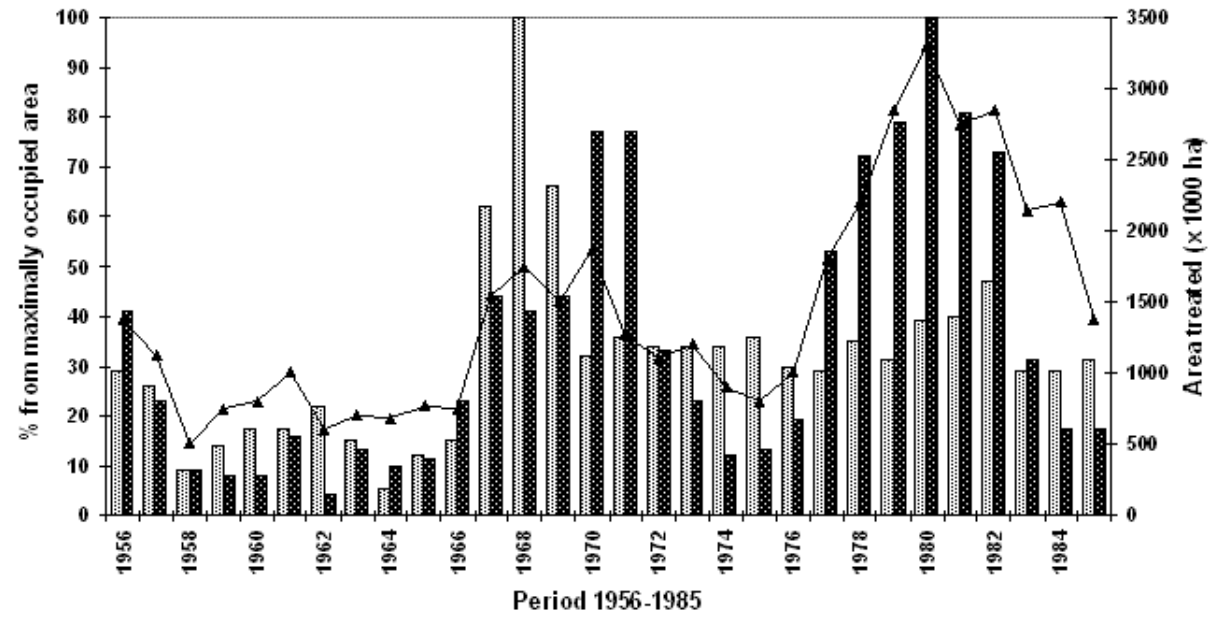
Fig. 1. Area (%) occupied by the Asiatic Migratory Locust and the Italian Locust, and area treated (ha) against all species of locusts in the USSR in 1956–1985. Source: Popov (1987) and Latchininsky et al.